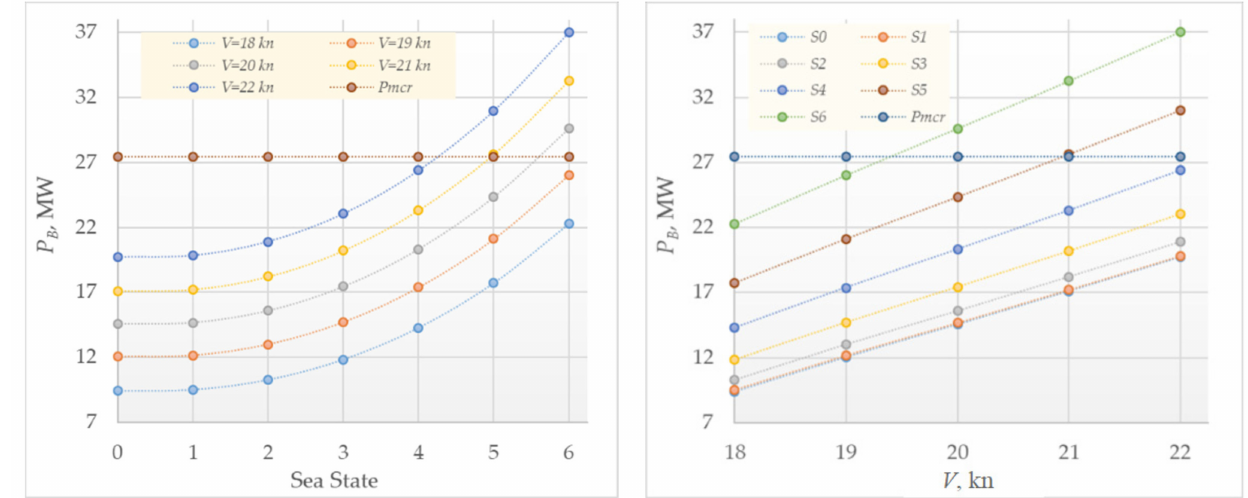
Figure 9. Balancing break power for various SI S ( left ) and V S ( right